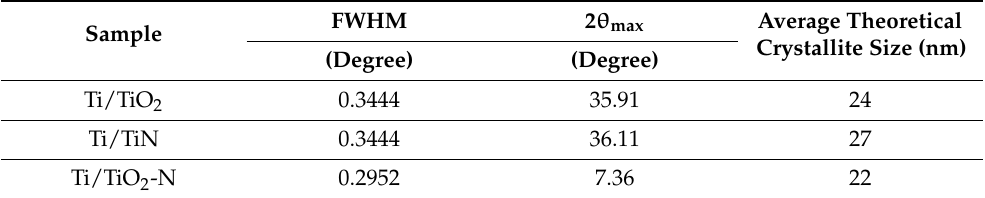
Table 1. The crystalline properties of the coatings.